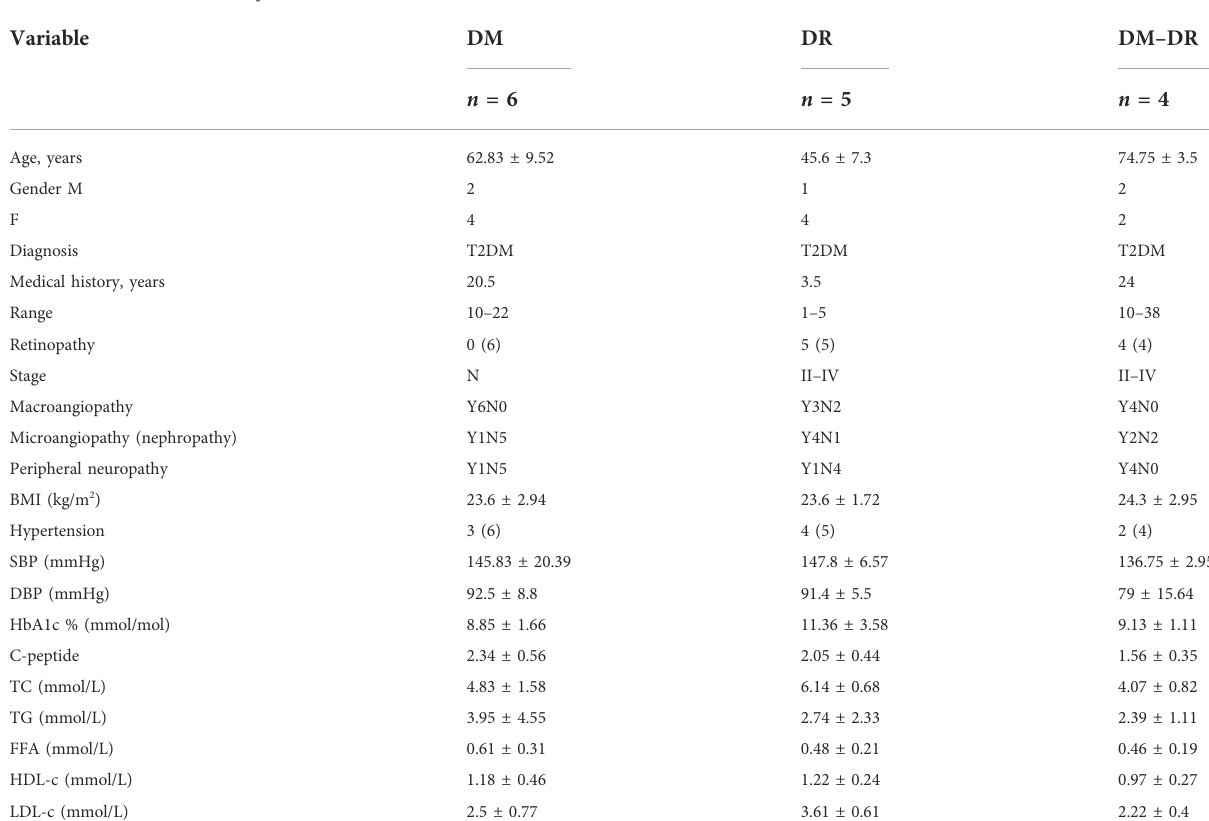
TABLE 1 Clinical data summary